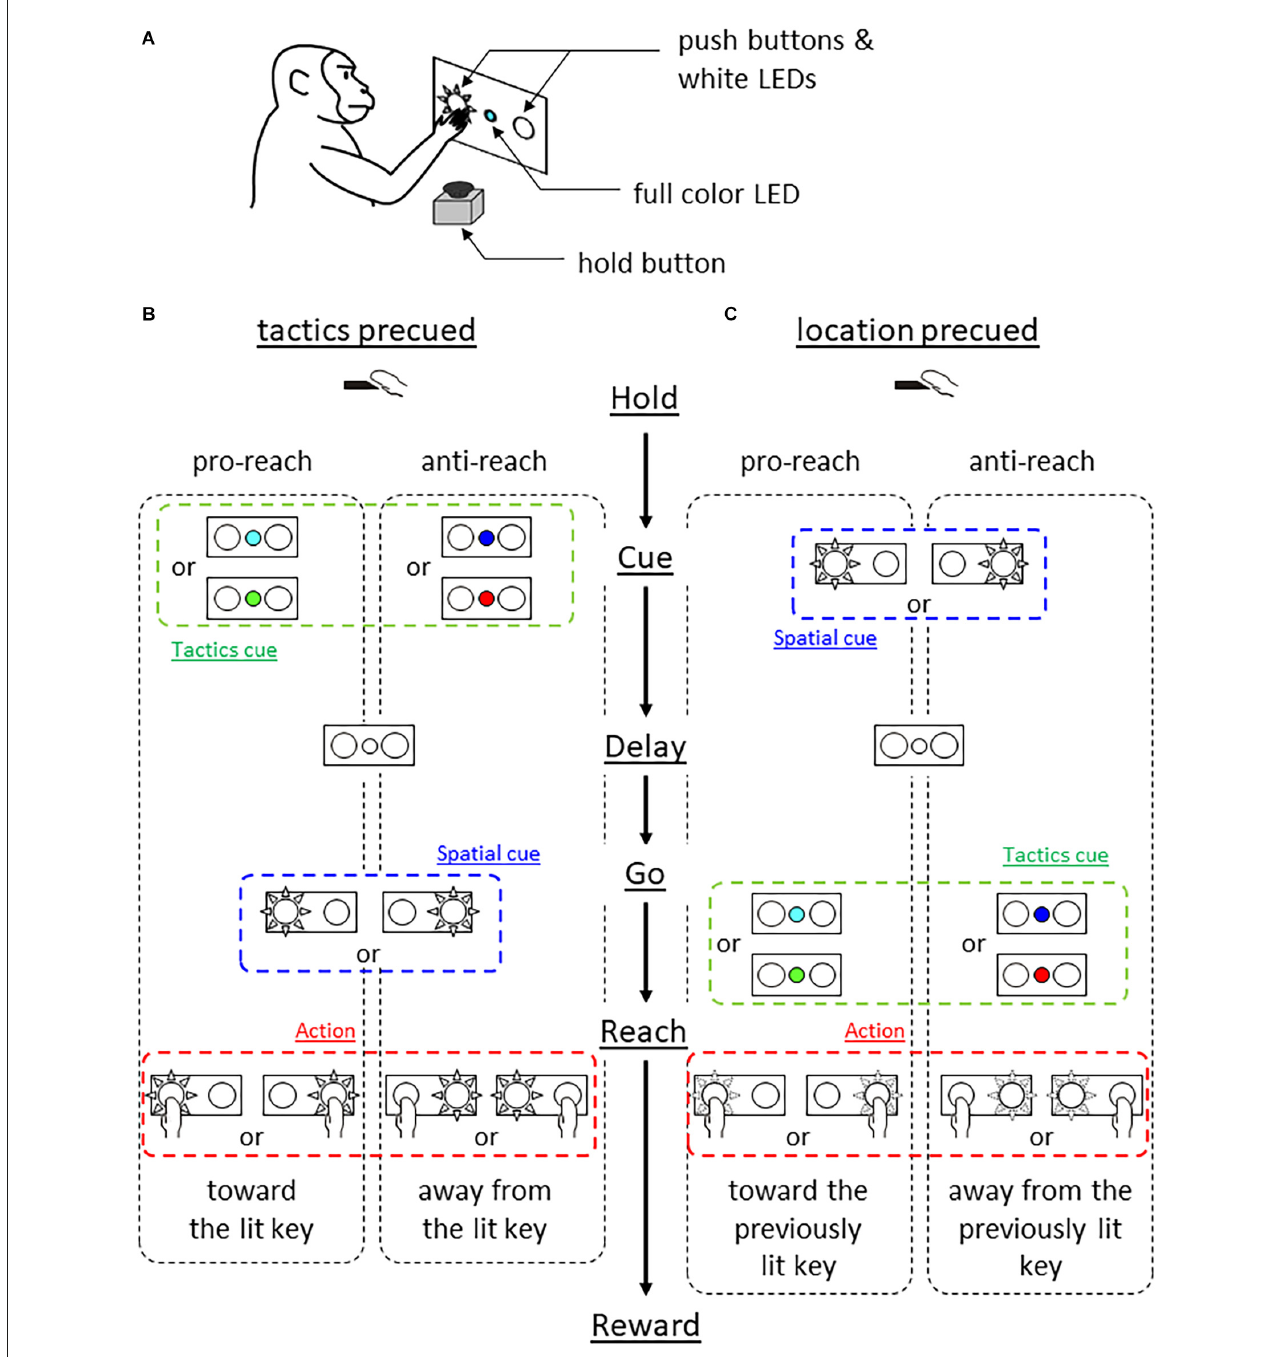
FIGURE1 Behavioral experiment. (A) Experimental setup. Monkey faced a panel equipped with a full color LED in the center and two push buttons which were back-illuminated by white LEDs. (B) Tactics-precued task . Following a hold period of 1 s, the center LED was turned on in one of the four colors for 500 ms. The color cue instructed the tactics (cyan and green for pro-reach, blue and red for anti-reach). After variable delay period (1–1.5 s, either the left or right push button was back-illuminated in white serving as the visuospatial cue and 1-kHz tone was simultaneously turned on, prompting the monkey’s response. Pro-reach trials required reaching toward the illuminated button while anti-reach required reaching away from the illuminated button. (C) Location-precued task . After the hold period, either the left or the right button was back-illuminated in white for 0.5 s serving as the visuospatial cue. A variable delay period (1–1.5 s) followed, then the center LED was turned on in one of the four colors, serving as the tactics cue simultaneously with the 1 kHz tone. The color-tactics association was the same as in the tactics-precued task. The monkey selected the appropriate action based on the remembered cue location and the given